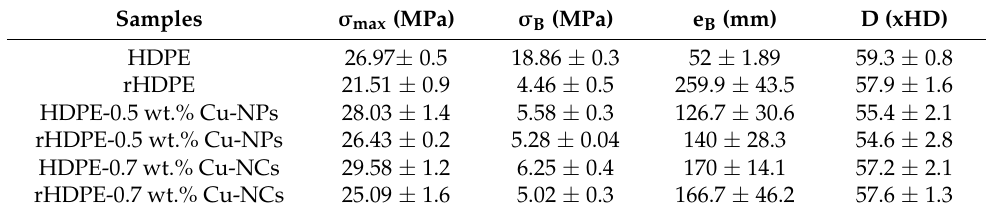
Table 2. Mechanical parameters estimated from stress–strain curves.